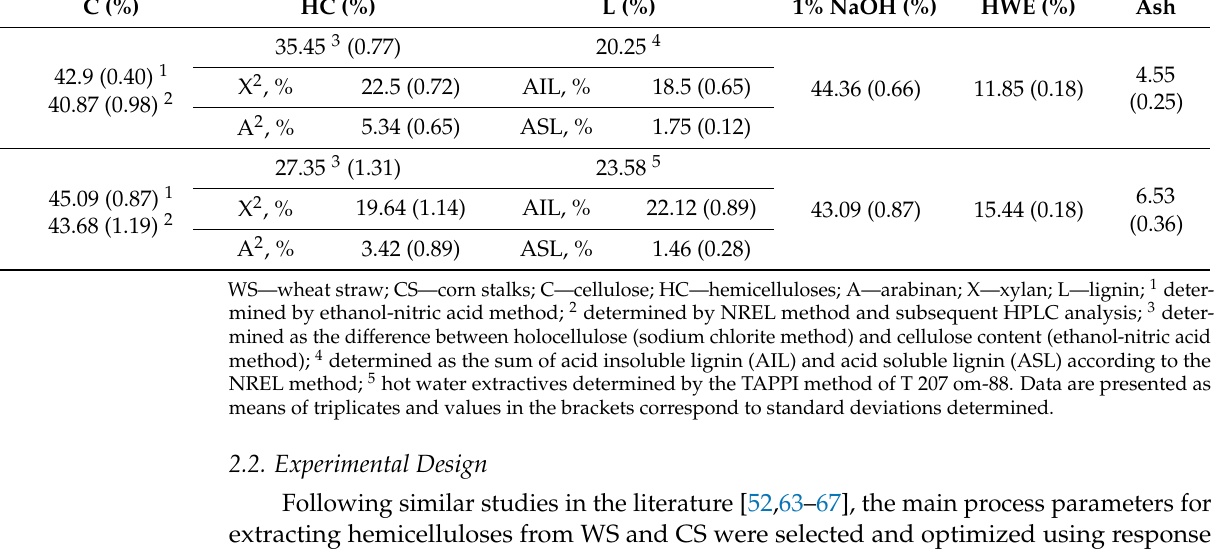
Table 1. Independent variables and variation range for the HAE of hemicelluloses from WS and CS. Independent Variables Measure Units Code Reaction time minutes X1 60 120 t Temperature ◦ C X2 80 120 T NaOH concentration wt.% X3 2 10 C NaOH